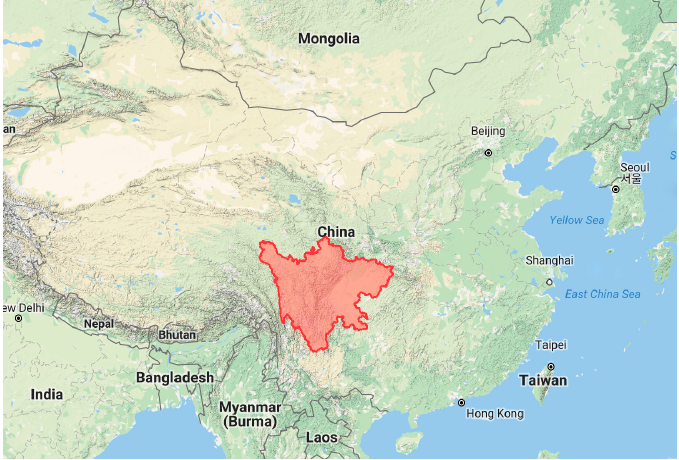
Figure 1. Partial map of China ( the area in red is Sichuan Province, which located in southwest China).